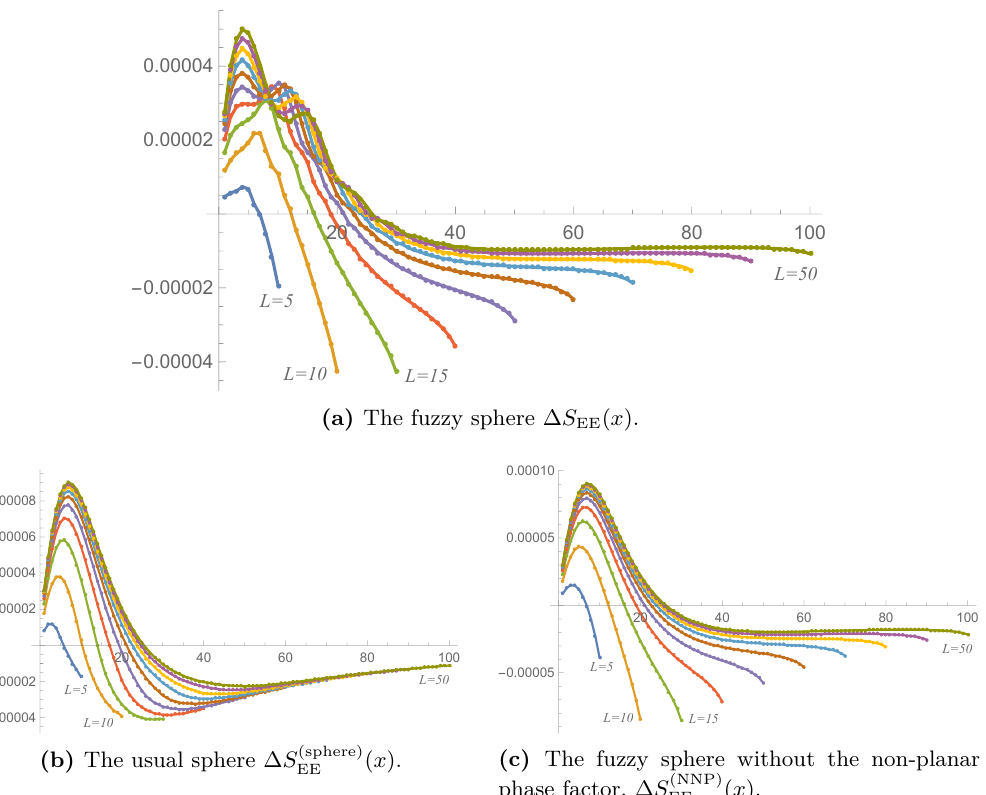
Figure 4 . The derivative of the EE of the usual sphere, the fuzzy sphere, and the fuzzy sphere without the non-planar phase factor, up to − λ 2 ln λ 2 / 16 R 2 . The horizontal axis is x . R is set to be 1. µ = 15 and L = 5 (left), 10 , 15 , · · · , 50